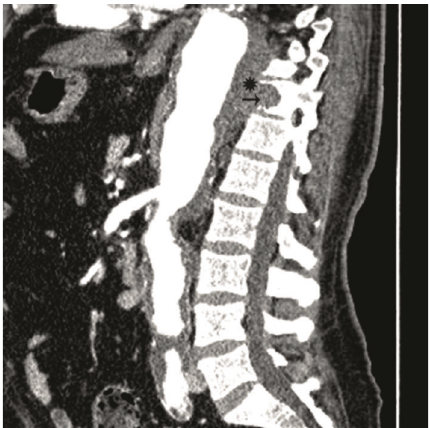
Figure 3: Contrast-enhanced multidetector CT angiography lateral MPR image shows chronic-contained aneurysm rupture ( ∗ ) of the aorta with vertebral erosion and lysis